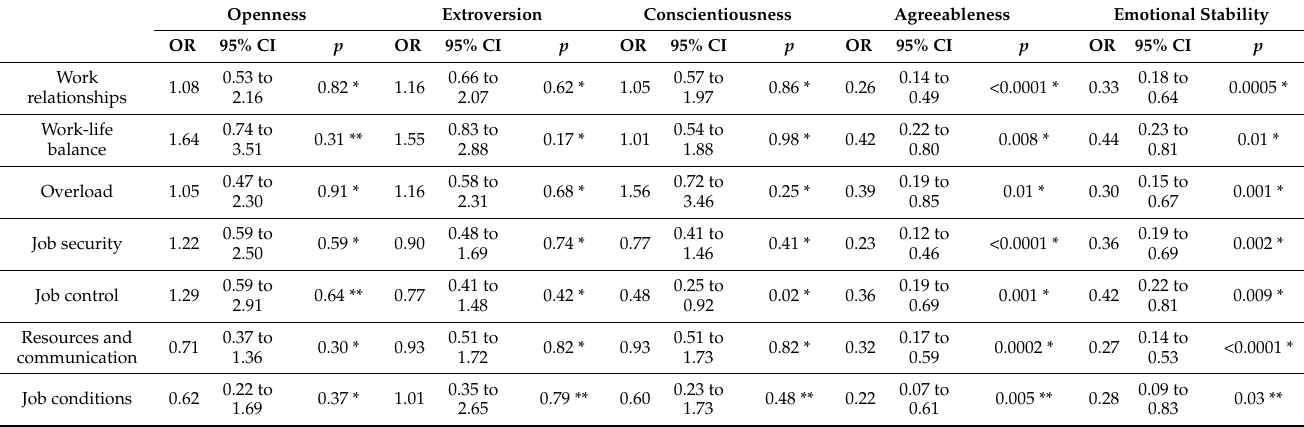
Table 6. Associations between personality dimensions and variables related to occupational